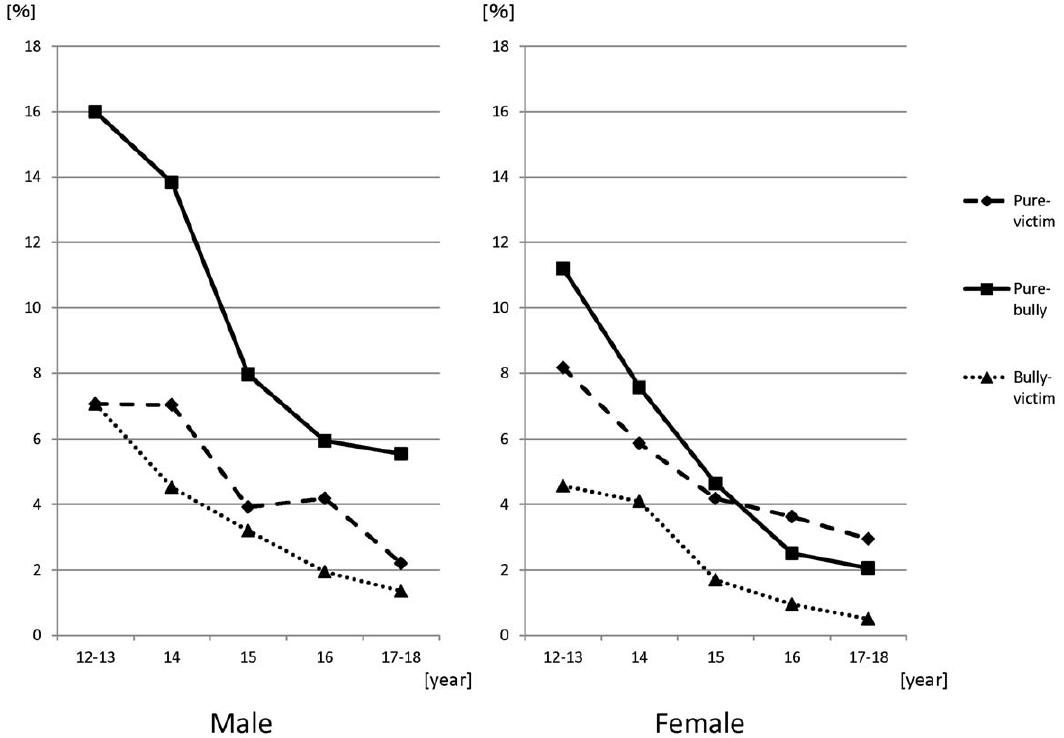
Figure 1. Changes of the prevalence of each bullying status by age. All three categories of the bullying status had a tendency of consistent decrease with age.